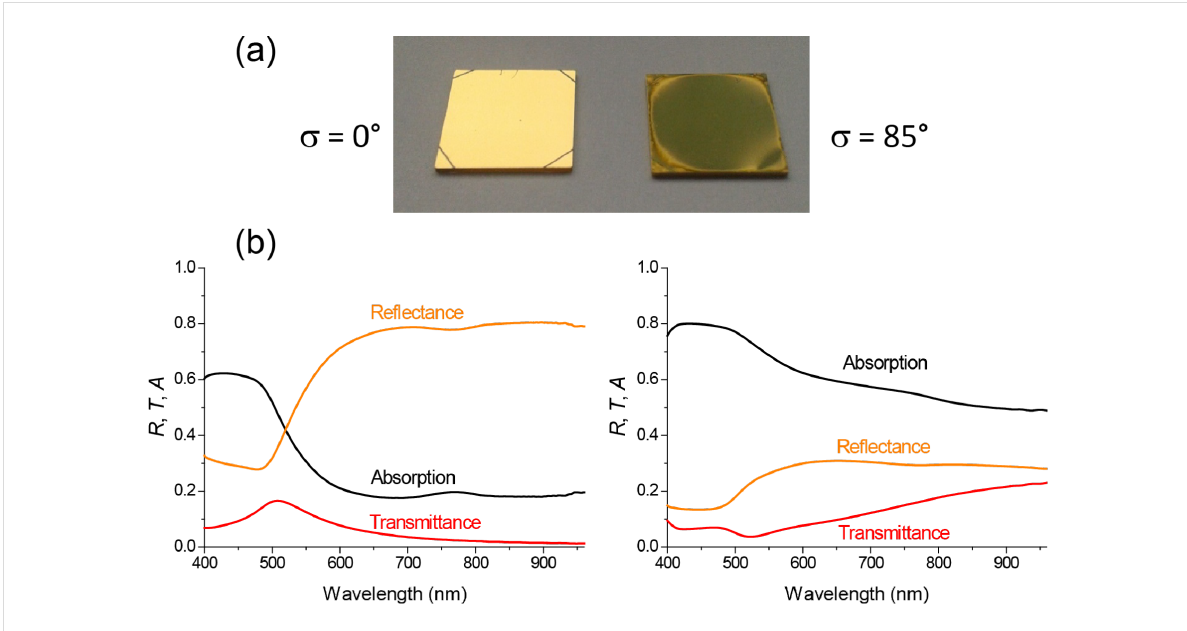
Figure 5: (a) Photograph of two samples prepared onto MgO substrates: a continuous Au thin film prepared with σ = 0° (left) and a nanostructured Au sample prepared with σ = 85° (right). (b) Transmittance, reflectance and absorption spectra of those samples.